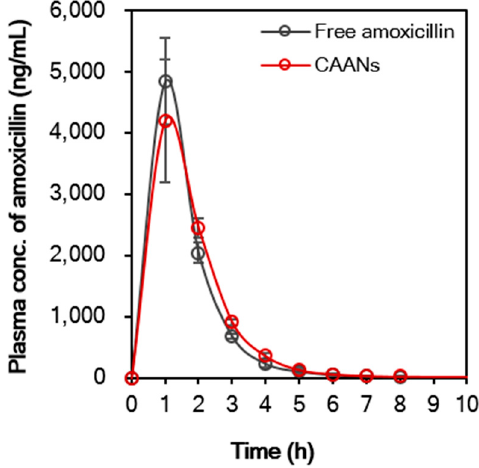
Figure 7. In vivo oral pharmacokinetic profile of free amoxicillin suspension and CAANs in a male CD ® (SD)IGS rat model. All data points are expressed as mean ± SD (n = 4). Table 1. Pharmacokinetic parameters of free amoxicillin suspension and CAANs. Parameters